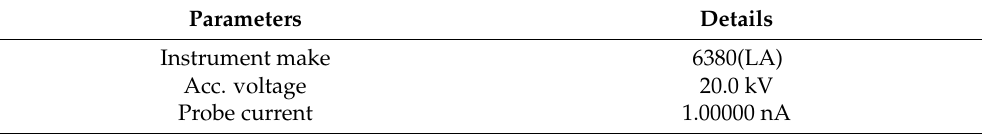
Table 8. Specification of EDX